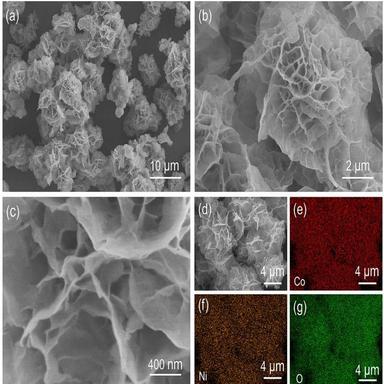
(a-d) SEM images of CoNi LDH NFs and the corresponding elemental mapping images of (e) Co, (f) Ni, and (g) O, respectively.